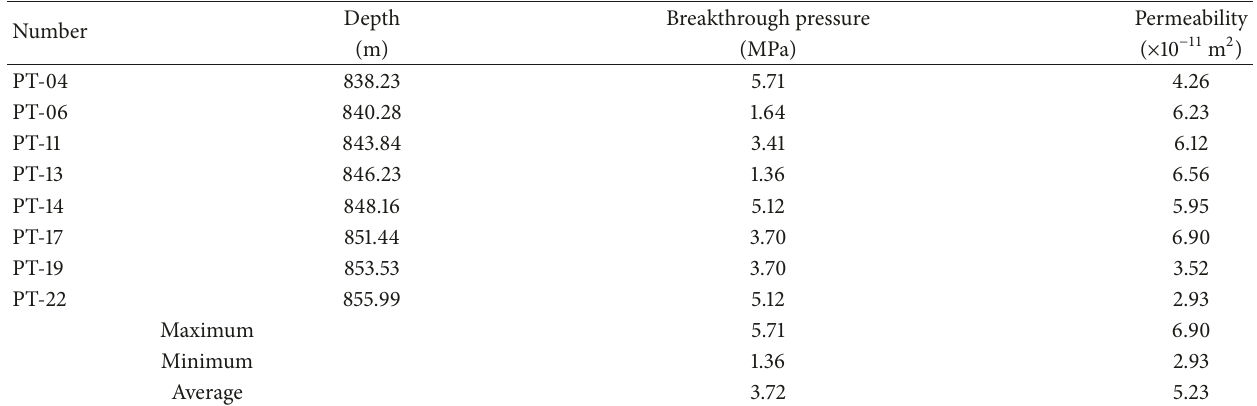
Table 2: The permeability and breakthrough pressure of Well